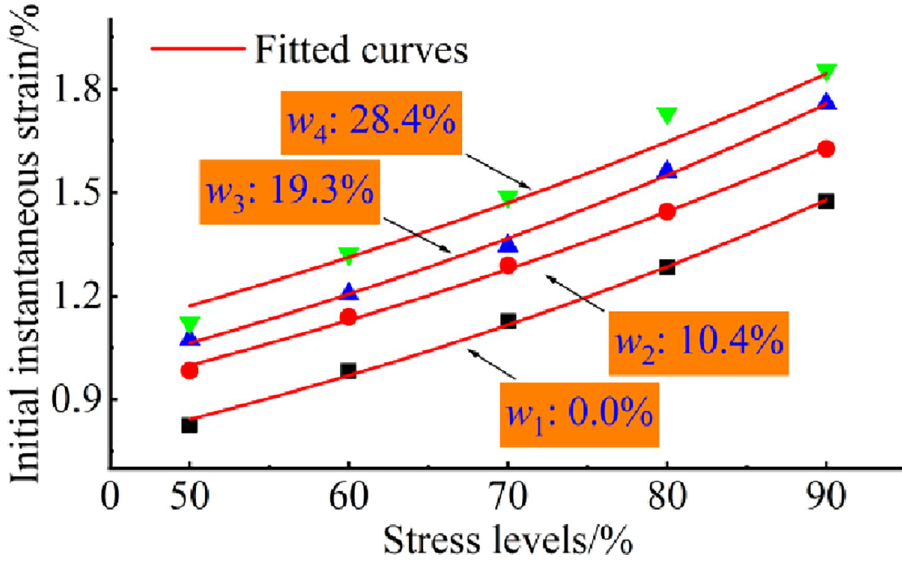
Fig 7. Steady-state variation curves for specimens subject to different stresses.